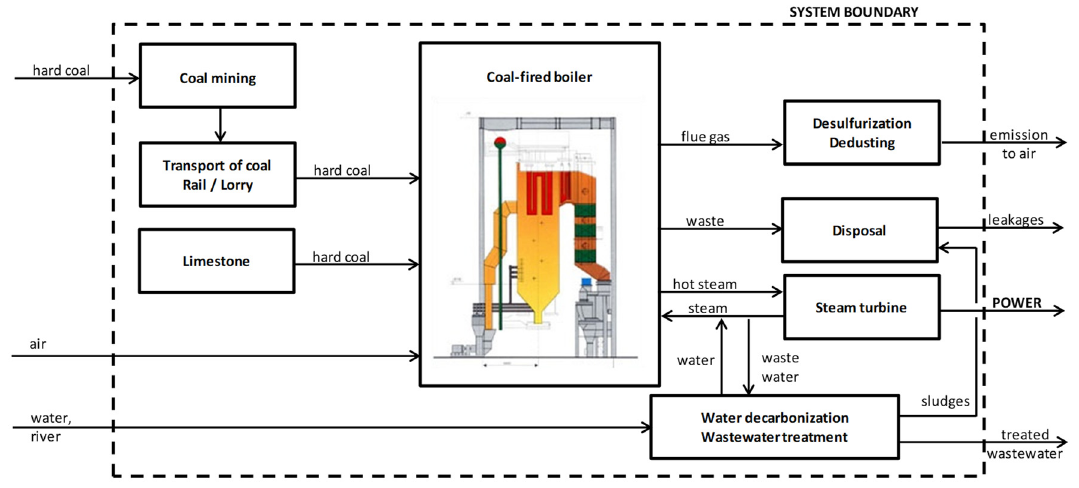
Figure 2. System boundary of the power plant.